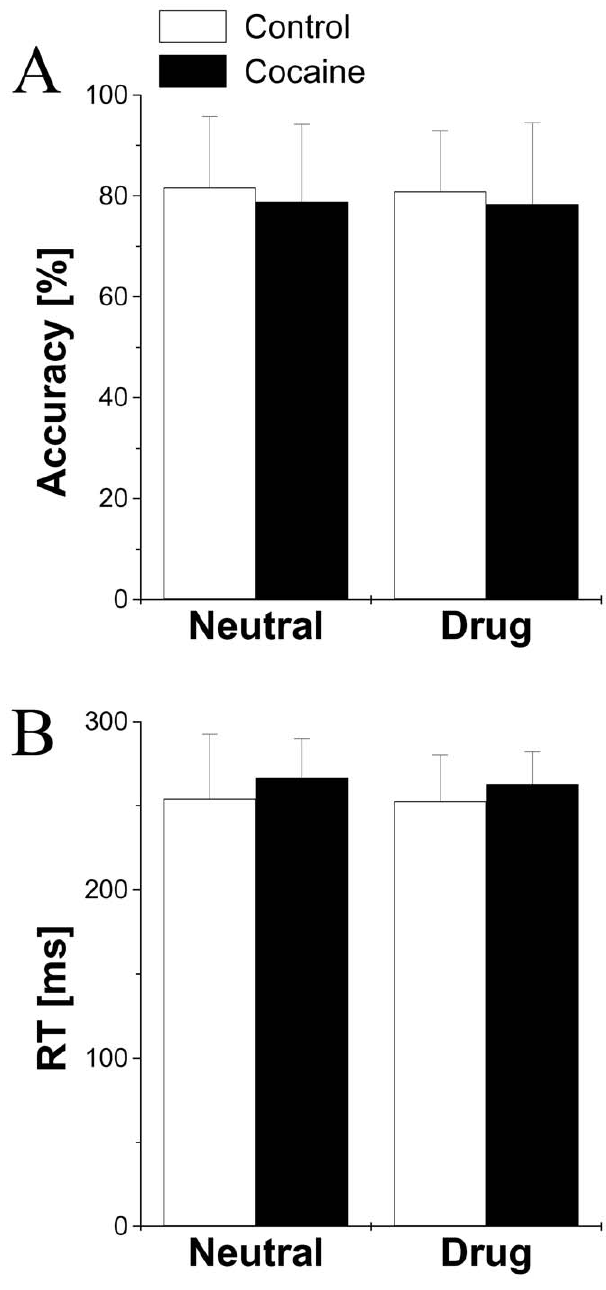
Figure 3. Behavioral data. Average performance accuracy (A) and reaction times (RT; B) during the drug-word (DW) paradigm for cocaine (N=20) and control (N=20) subjects.